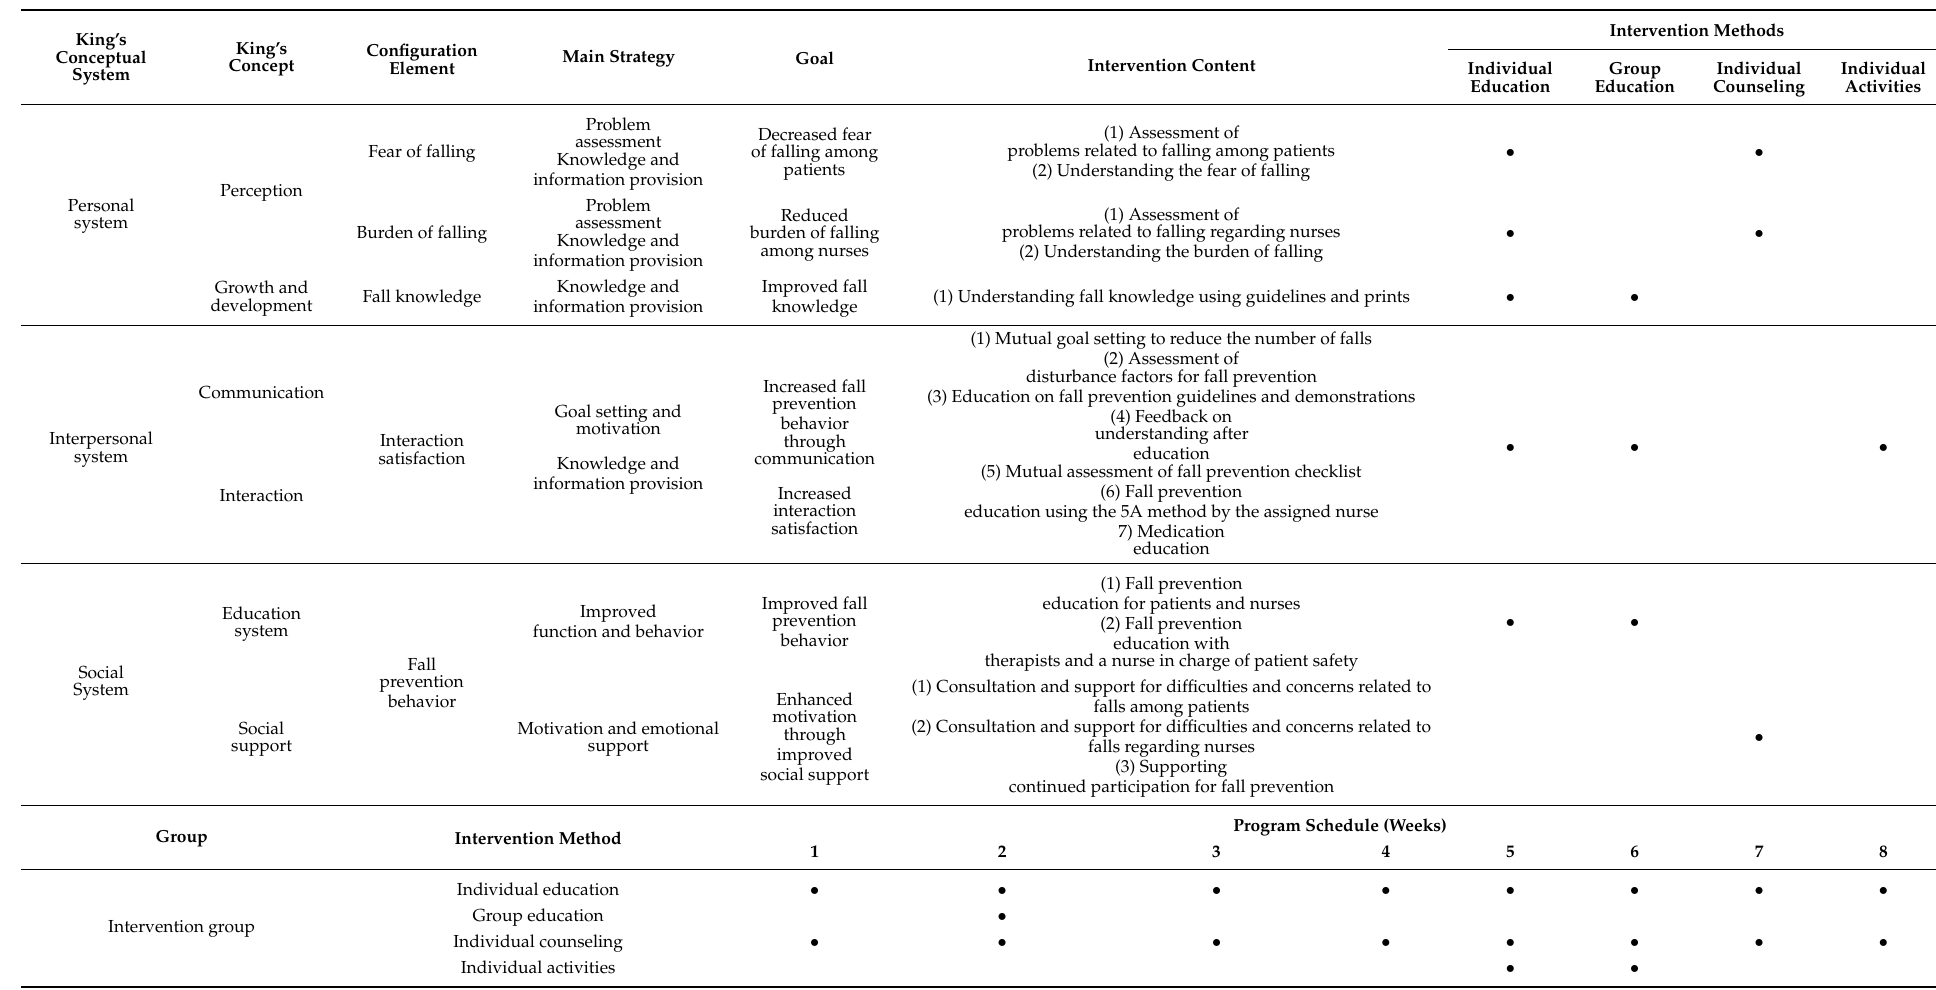
Table 1. Basic principles and implementation schedule of the program based on King’s goal attainment